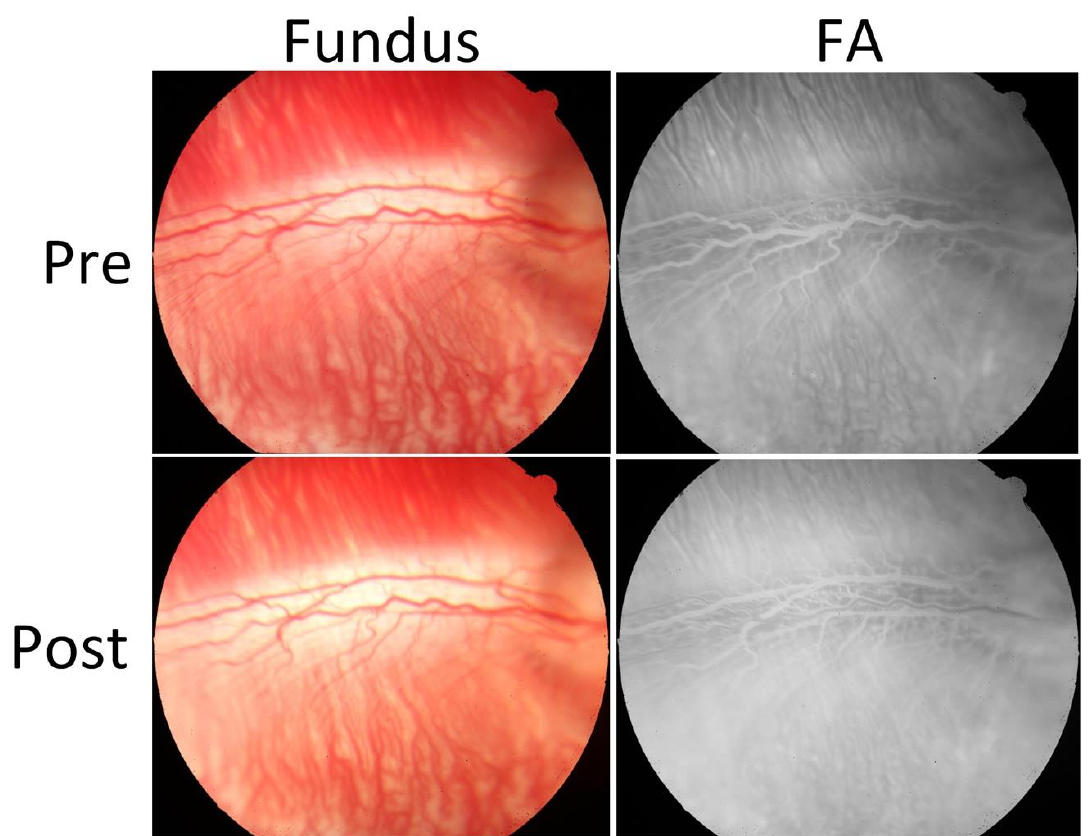
Figure A1. Color fundus photography of the retina before and after dual PAM and OCT experiment.